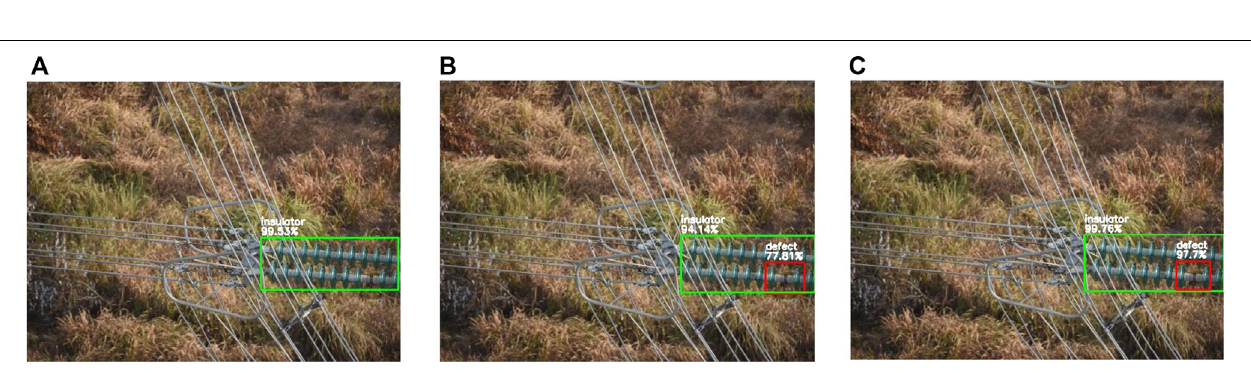
FIGURE 9 | Aerial image with the half insulator: (A) cascade R-CNN, (B) YOLOv5, and (C)